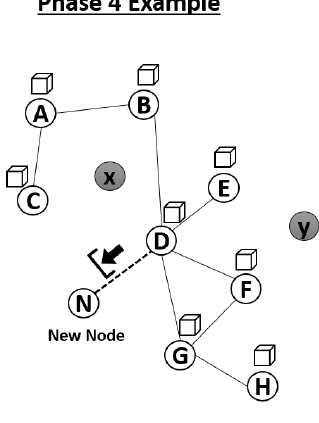
Figure 10. Demonstration of Phase